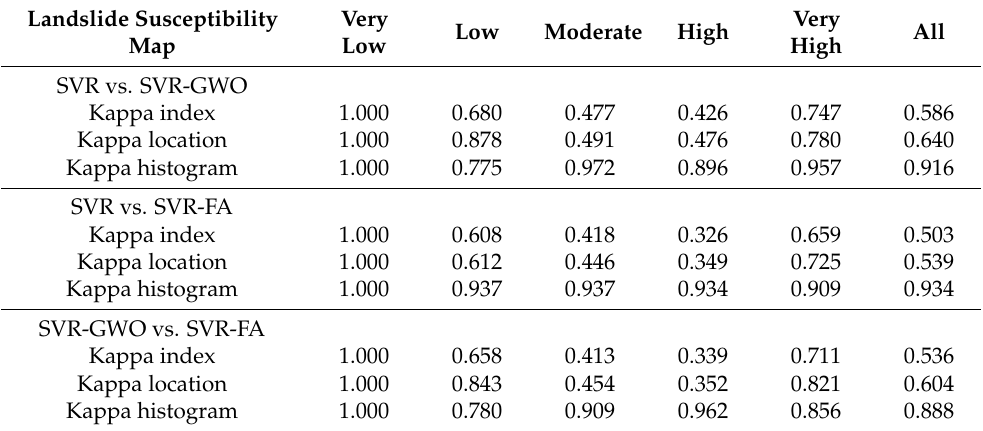
Table 3. Kappa statistics of landslide susceptibility